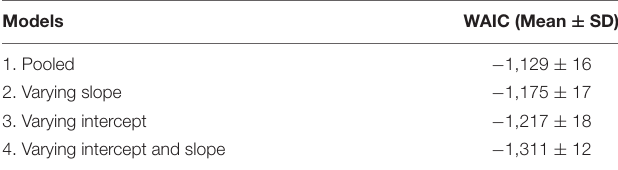
TABLE 2 | Models’ fitness of norm of error velocity.